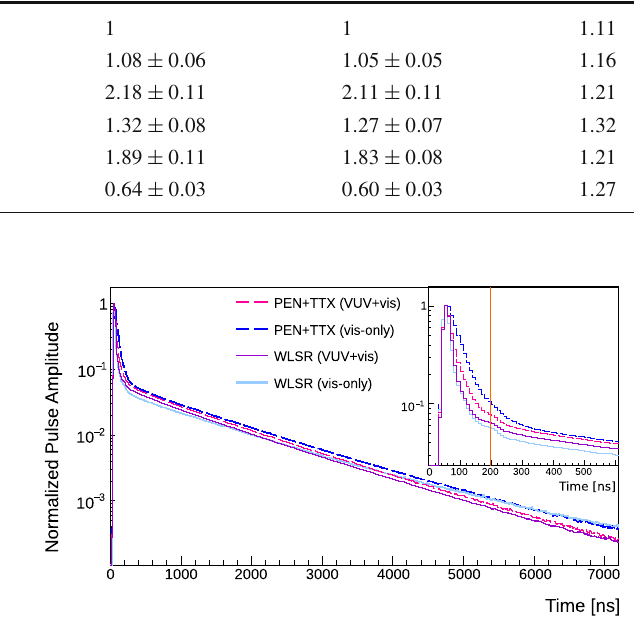
Fig. 12 Stacked waveforms of different measurements normalized to their peak values. The position defining the prompt signal is marked in orange